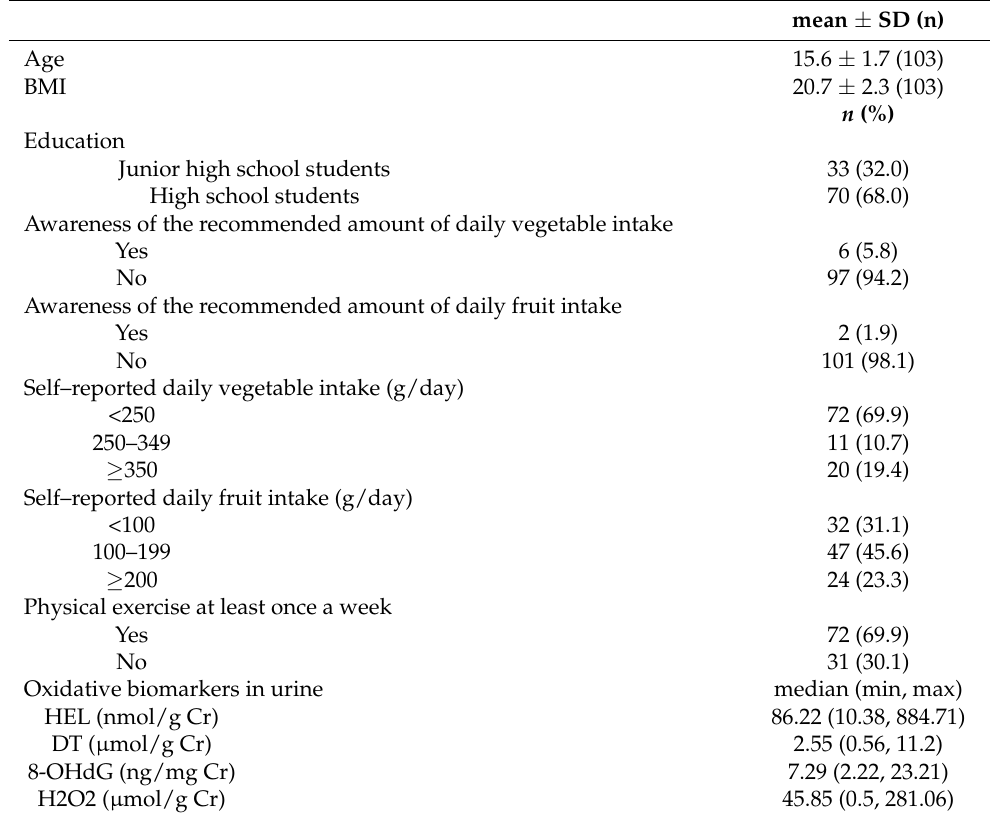
Table 1. Participant characteristics.